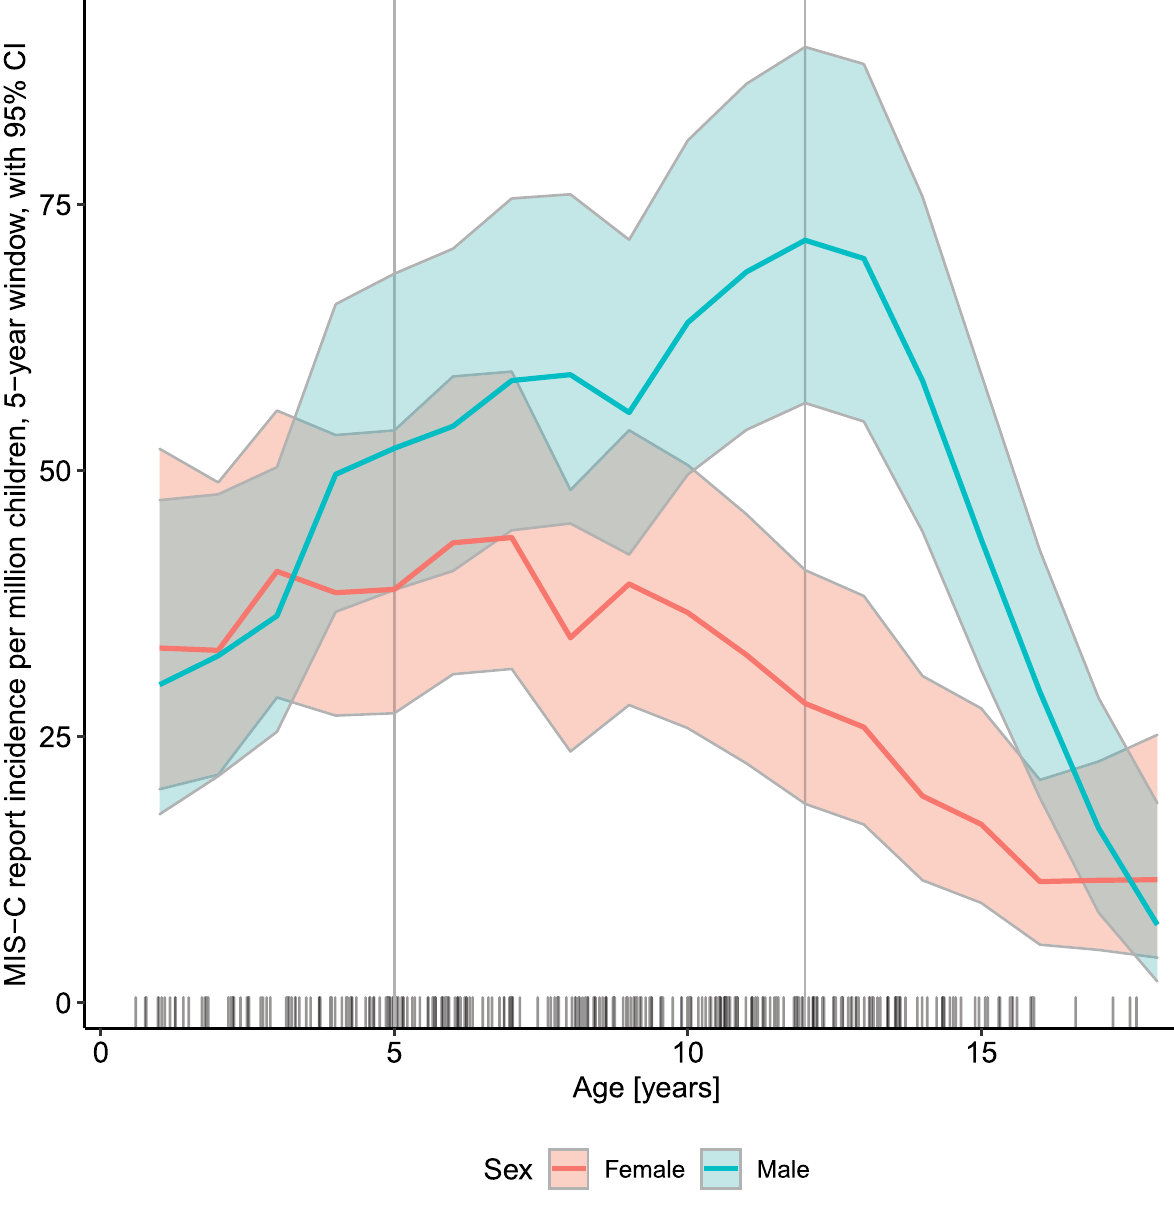
Figure 2. Incidence of reported MIS-C cases within the Polish population of children aged 0–18 years, according to age and